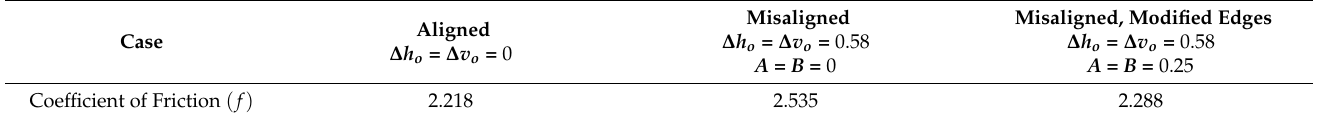
Table 2. The values for the coefficient of friction calculations for different